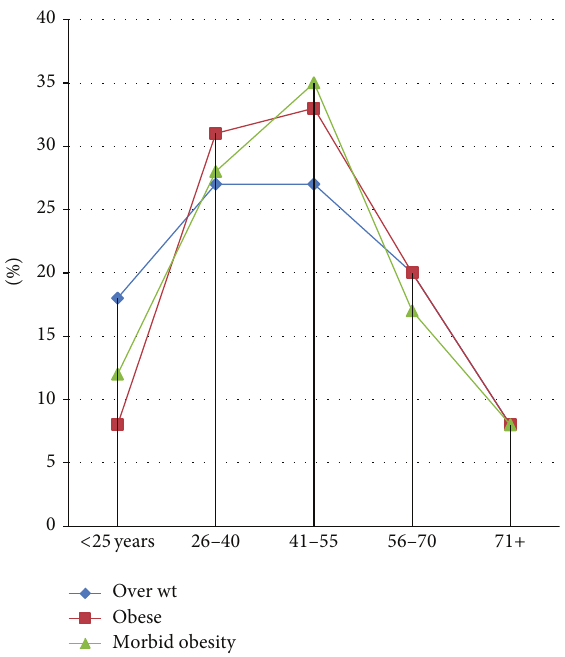
Figure 2: Description of the proportions of obesity categories by age ranges.